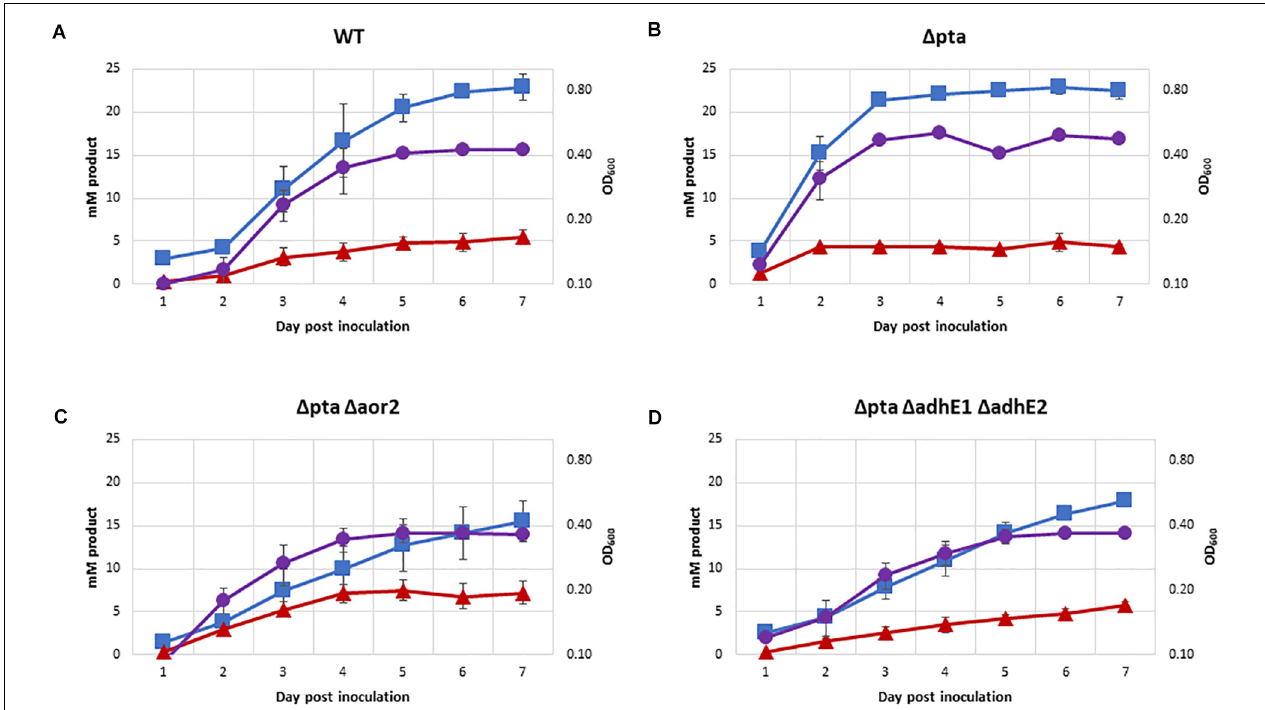
FIGURE 5 | Growth and fermentation products of strains on PETC with 100% CO. Strains were grown over 7 days with fermentation products and growth monitored, with approximately a 5:1 headspace to liquid ratio. Acetate as blue squares, ethanol as red triangles, OD 600 as purple circles. (A) Wild type, (B) (cid:49) pta , (C) (cid:49) pta (cid:49) aor2 , and (D) (cid:49) pta (cid:49) adhE1 (cid:49)